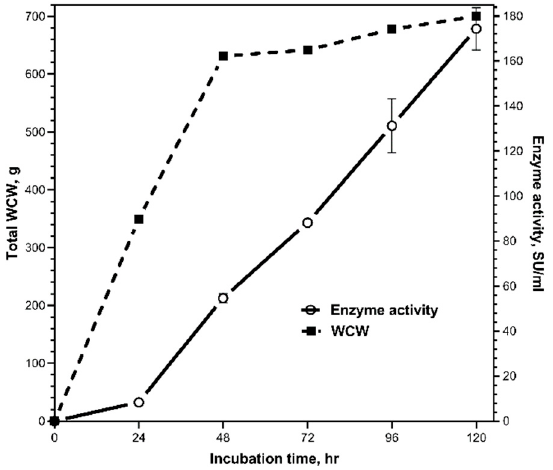
Figure 2. Lab-scale production of BacChym by the yeast P. pastoris in the 50 L bioreactor. WCW: wet cell